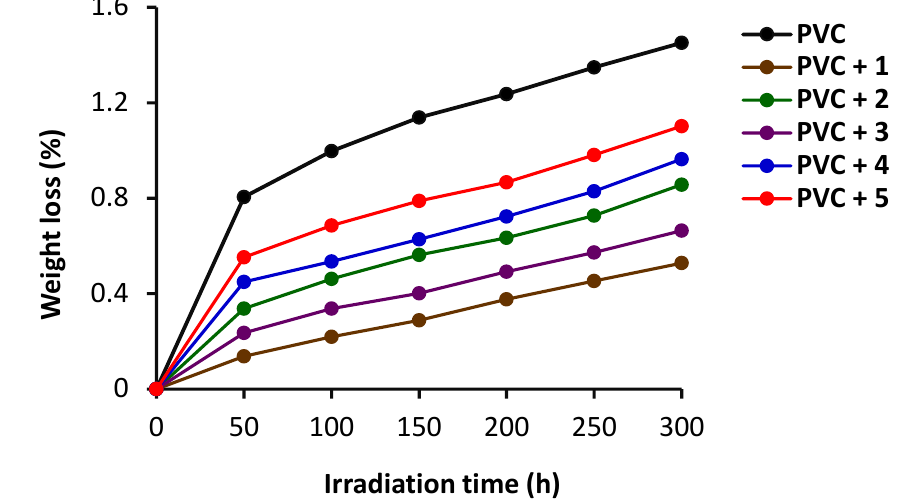
Figure 7. Weight loss (%) of the irradiated PVC films.